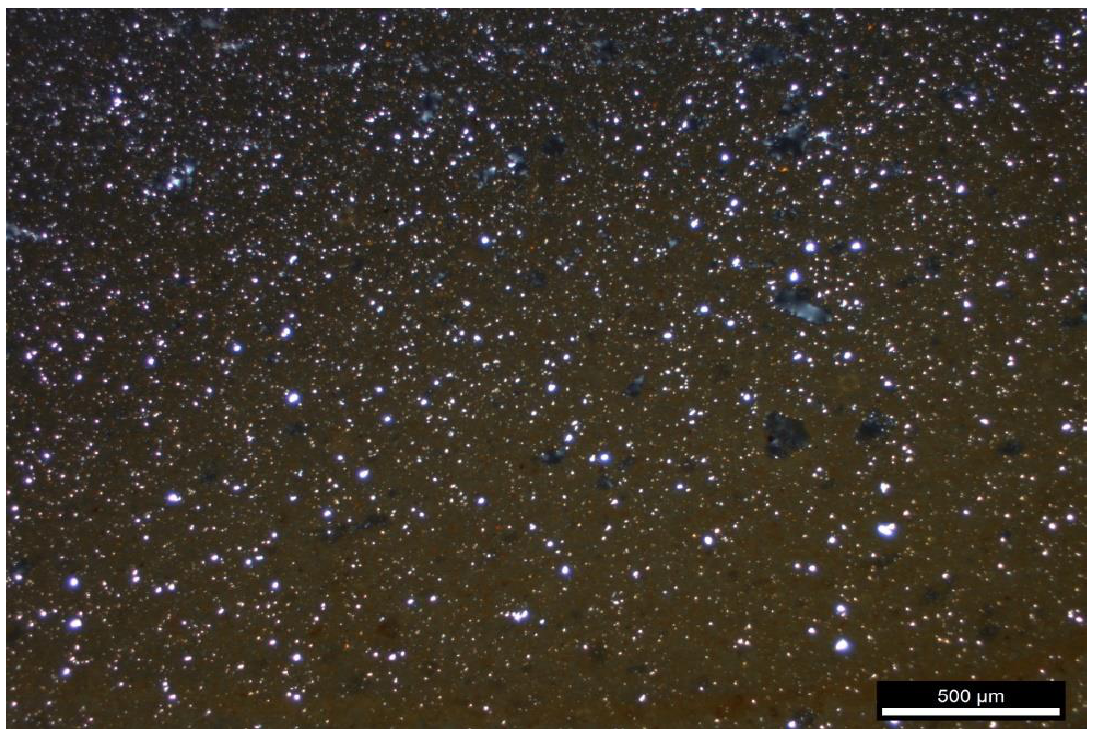
Figure 15. Photomicrograph of a typical sample (AK12-63) in SAR 11 showing an unaltered groundmass under crossed- polars. Image by William Gilstrap.